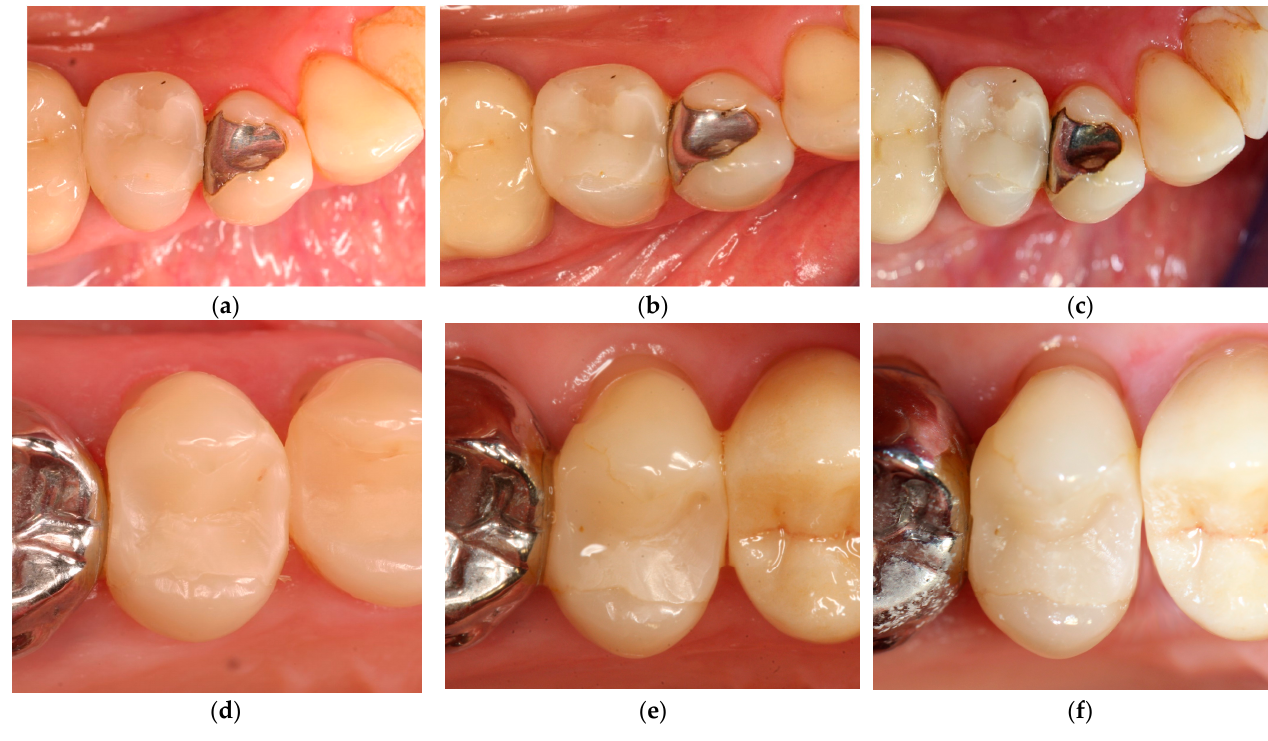
Figure 5. Clinical situation of Pat. No. 16: filling 45 mod without flowable composite: control group, all criteria were rated Code Alpha: ( a ) baseline; ( b ) after 12 months; and ( c ) after 24 months. Clinical situation of filling 15 mod with flowable composite as intermediate liner: test group, all criteria Code Alpha except margin discoloration was evaluated as Code Beta: ( d ) baseline; ( e ) after 12 months; and ( f ) after 24 months.